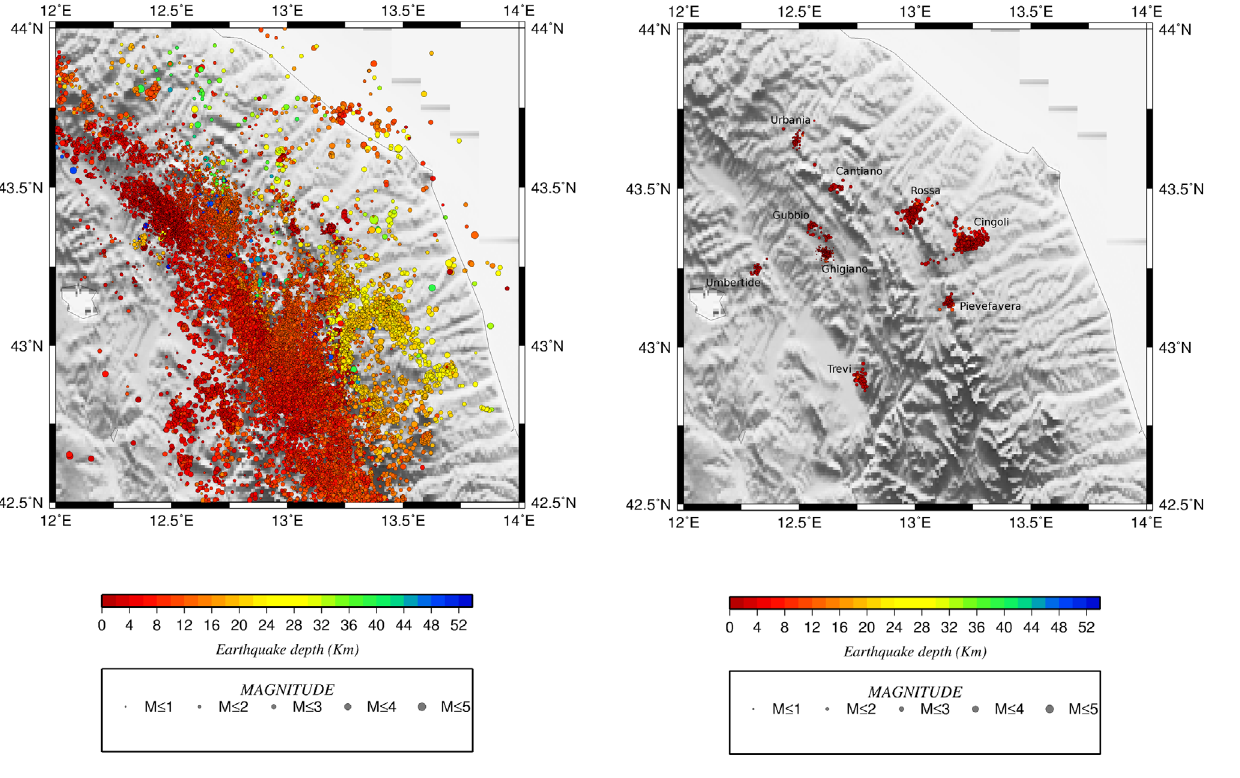
Figure 11. Map of the events classified as “non-tectonic source”. Note that even some strongly mis-located events were included in the catalogue, by means of the waveform